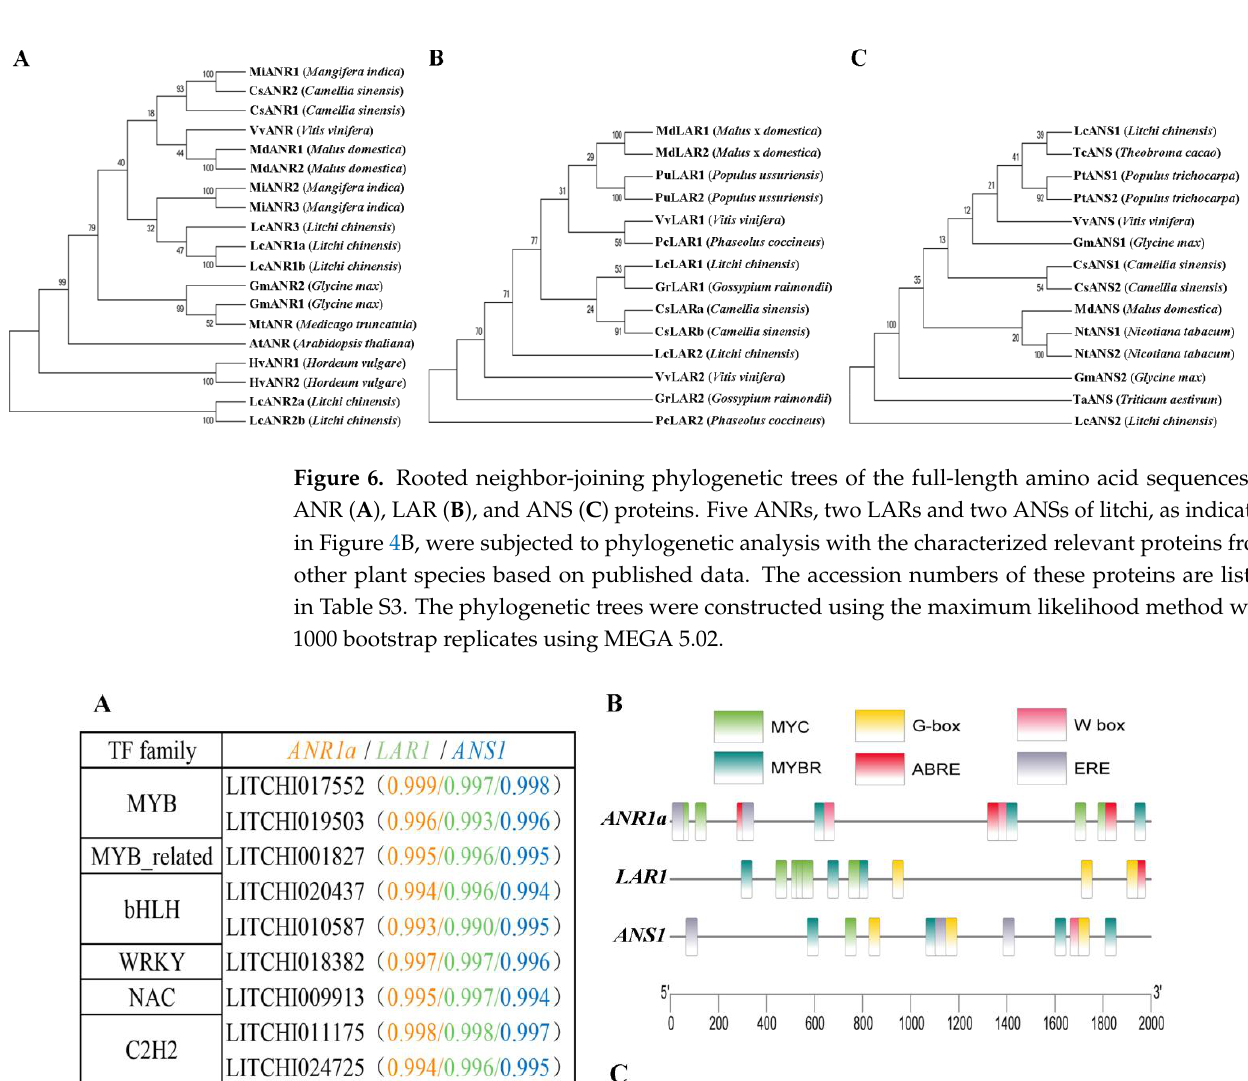
10 of 19 Table 1. Prediction of the biochemical characteristics of ANR, LAR, and ANS proteins. Gene ID